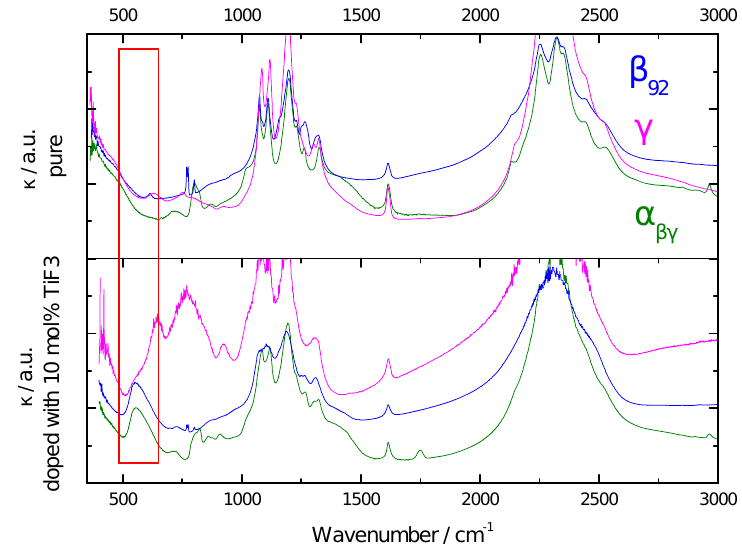
Figure 4. IR spectra for as-received (upper panel) and α βγ -, β 92 and γ with 10 mol% of TiF 3 . External modes corresponding to lattice vibrations in TiF 3 are marked with a red